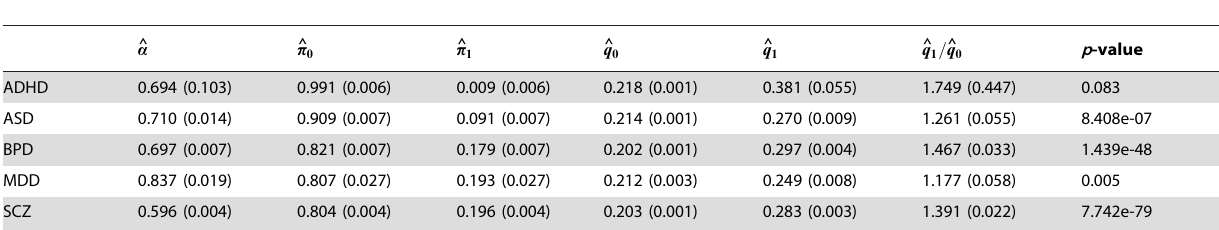
Table 1. Single-GWAS analysis of five psychiatric disorders using the CNS gene set as the annotation data.